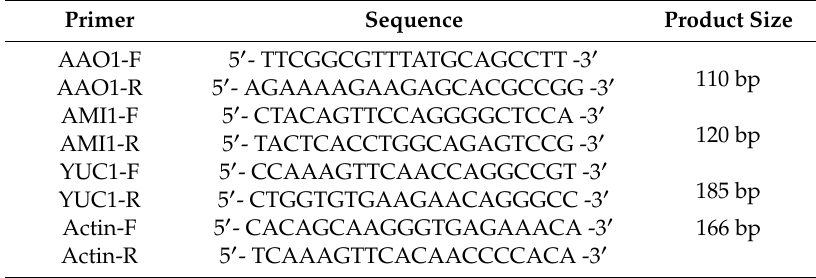
Table 1. Primers used for qRT-PCR analysis of AAO1 , AMI1 , and YUC1